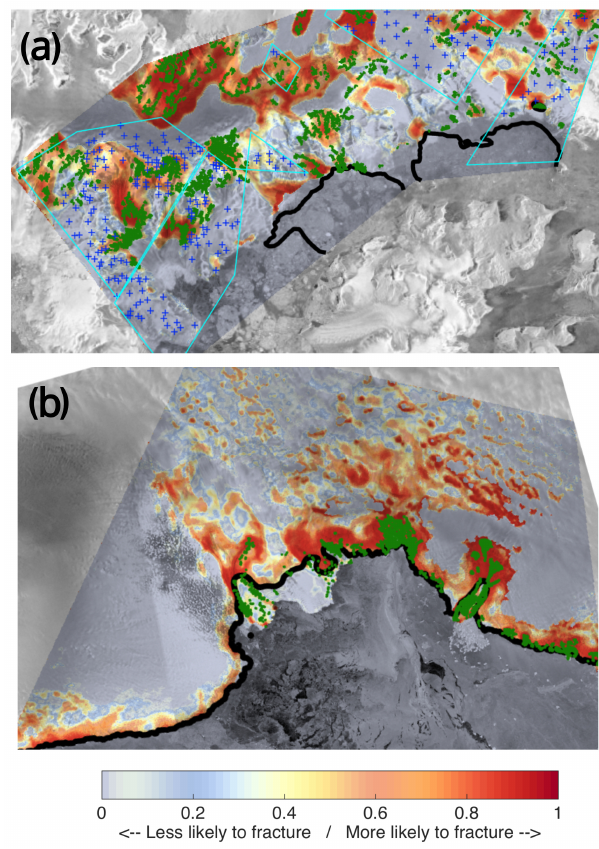
Figure 6. Modelled probability of a fracture for group 2, Larsen A IS (a) , and group1: Vanderford IS (b) . Labels are the same as in Fig.